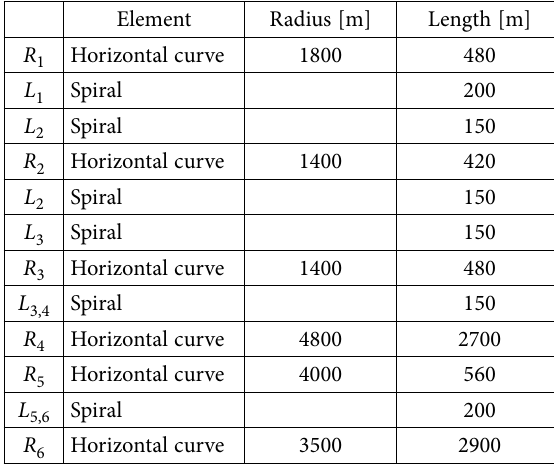
Table 1. Horizontal elements on the analysed section